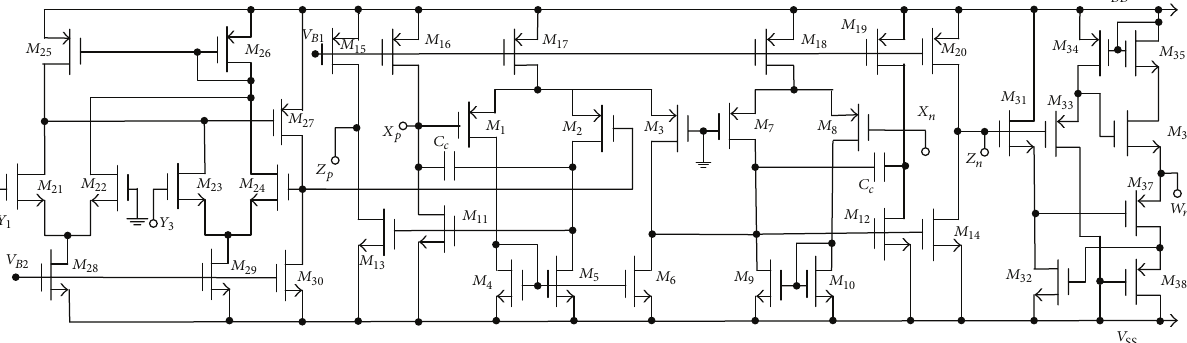
Figure 2: CMOS implementation of DD-DXCCII.